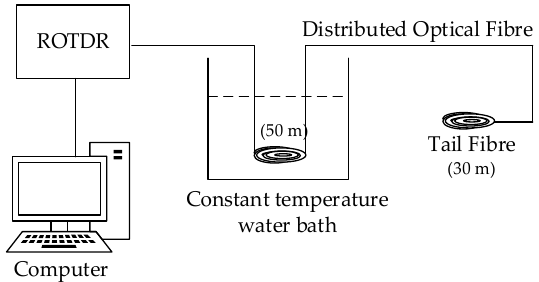
Figure 11. Distributed optical fibre temperature calibration system.